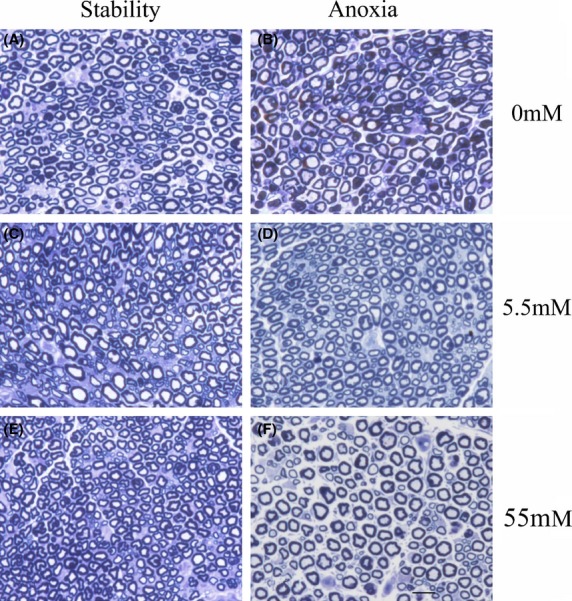
Toluidine Blue stained nerve cross-sections after resin embedding at 40×. (A) Nerve maintained in the fully oxygenated state with 0 mmol/L glucose, (B) Nerve subjected to intermittent anoxia with 0 mmol/L glucose, (C) Nerve maintained in the fully oxygenated state with 5.5 mmol/L glucose, (D) Nerve exposed to intermittent anoxia with 5.5 mmol/L glucose, (E) Nerve maintained in the continuously oxygenated state with 55 mmol/L glucose, and (F) Nerve subjected to intermittent anoxia with 55 mmol/L glucose. The shrinkage of the axons that were continuously oxygenated but exposed to hyperosmolar glucose and the enlargement of the axons of the nerves exposed to anoxia with hyperosmolar glucose or exposed to hypoglycemia is clear. The scale bar at the lower right indicates 20 microns.